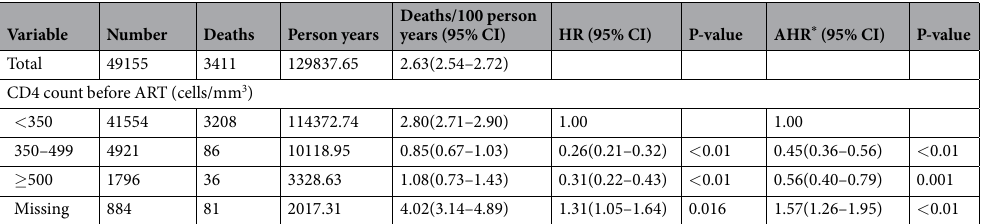
Table 5. Effects of CD4 count before ART on death in HIV-infected patients who started ART between 2010 and 2015 in Guangxi, China. * HR = hazard ratio; AHR = adjusted hazard ratio; covariates of the adjusted model included: age, sex, marital status, route of HIV infection, WHO clinic stage before ART, initial ART regimen, year initiated ART.